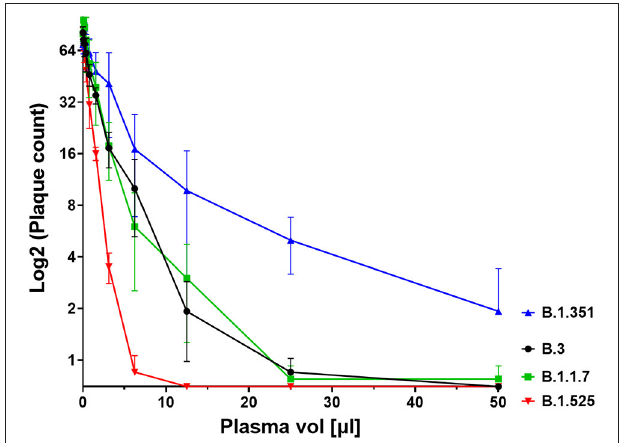
FIGURE 2 | Plaque count after neutralisation assay with serial dilutions of the patient’s serum on SARS-CoV-2 variants B.3, B.1.1.7, B.1.351, and B.1.525. The capacity of the serum to neutralise the different variants was correlated to the prevention of plaque formation. The plasma sample was diluted between a range of 1:4 (50 µ l in 200 µ l, see x axis) and 1:2048 to assess its titer for neutralisation. Results of four independent experiments are shown. Variations in NT values between experiments are indicated by an error bar.